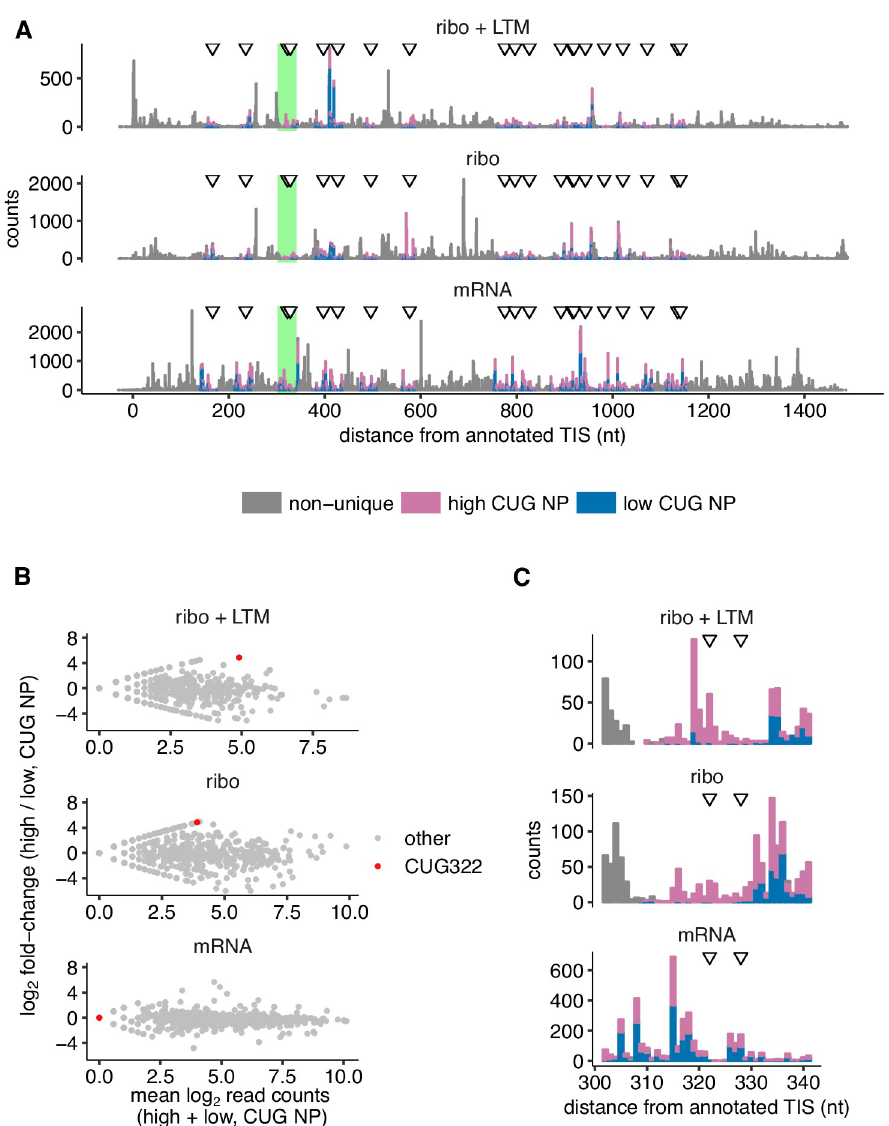
Fig 4. Translation initiation at CUG codons in influenza nucleoprotein. (A) Coverage of Ribo-seq + LTM, Ribo- seq, and RNA-seq reads that can be uniquely aligned to either the high CUG NP variant or the low CUG NP variant, along with reads that cannot be uniquely assigned. P-site counts are shown for Ribo-seq and Ribo-seq + LTM assays. 5’-end counts are shown for RNA-Seq. Data are plotted as a stacked bar graph. Locations of the 20 CUG codons that are present in high CUG NP and synonymously mutated in low CUG NP are indicated by arrows. (B) The ratio of high CUG NP to low CUG NP coverage from panel A is plotted against their sum along the horizontal axis. (C) The green-highlighted region in panel A around the CUG322 codon is shown at greater horizontal magnification. Data shown for +vir sample. See S15 Fig for +ifn +vir